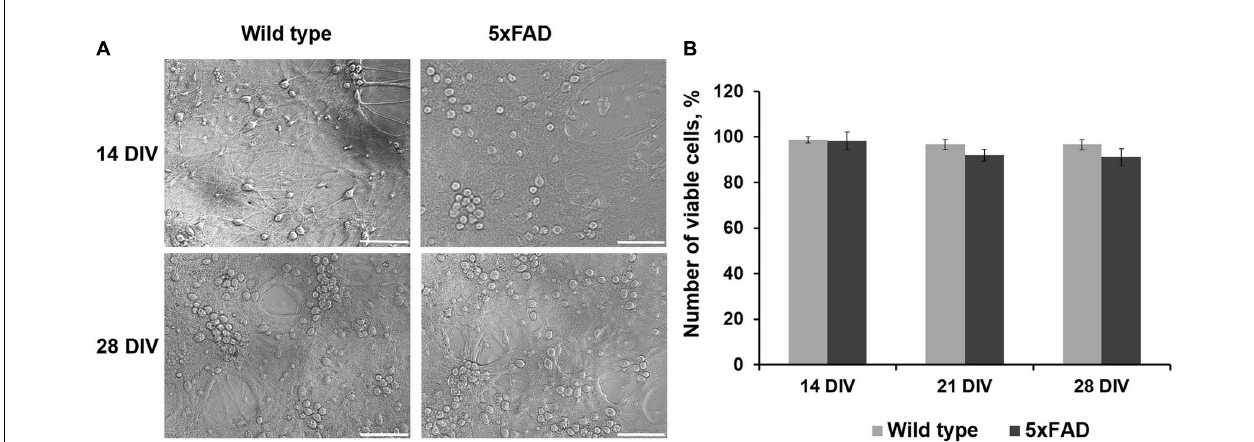
FIGURE 2 | (A) Representative light field images of primary hippocampal cultures obtained from wild-type and 5xFAD mice. Scale bar – 100 µ m. Comparative morphological assessment did not reveal significant changes between primary hippocampal cultures obtained from wild-type and 5xFAD murine embryos over 28 DIV. (B) Analysis of cell viability in primary hippocampal cultures obtained from wild-type and 5xFAD murine embryos. There was no decrease in cell viability in either experimental group.